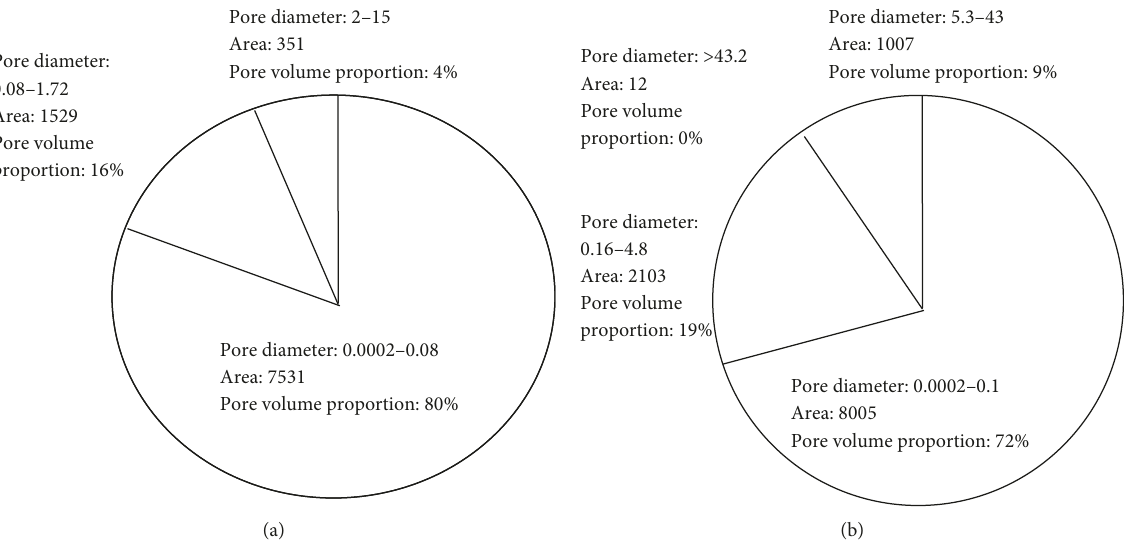
Figure 4: Pie graphs of pore diameter and volume. (a) Three peak. (b) Four